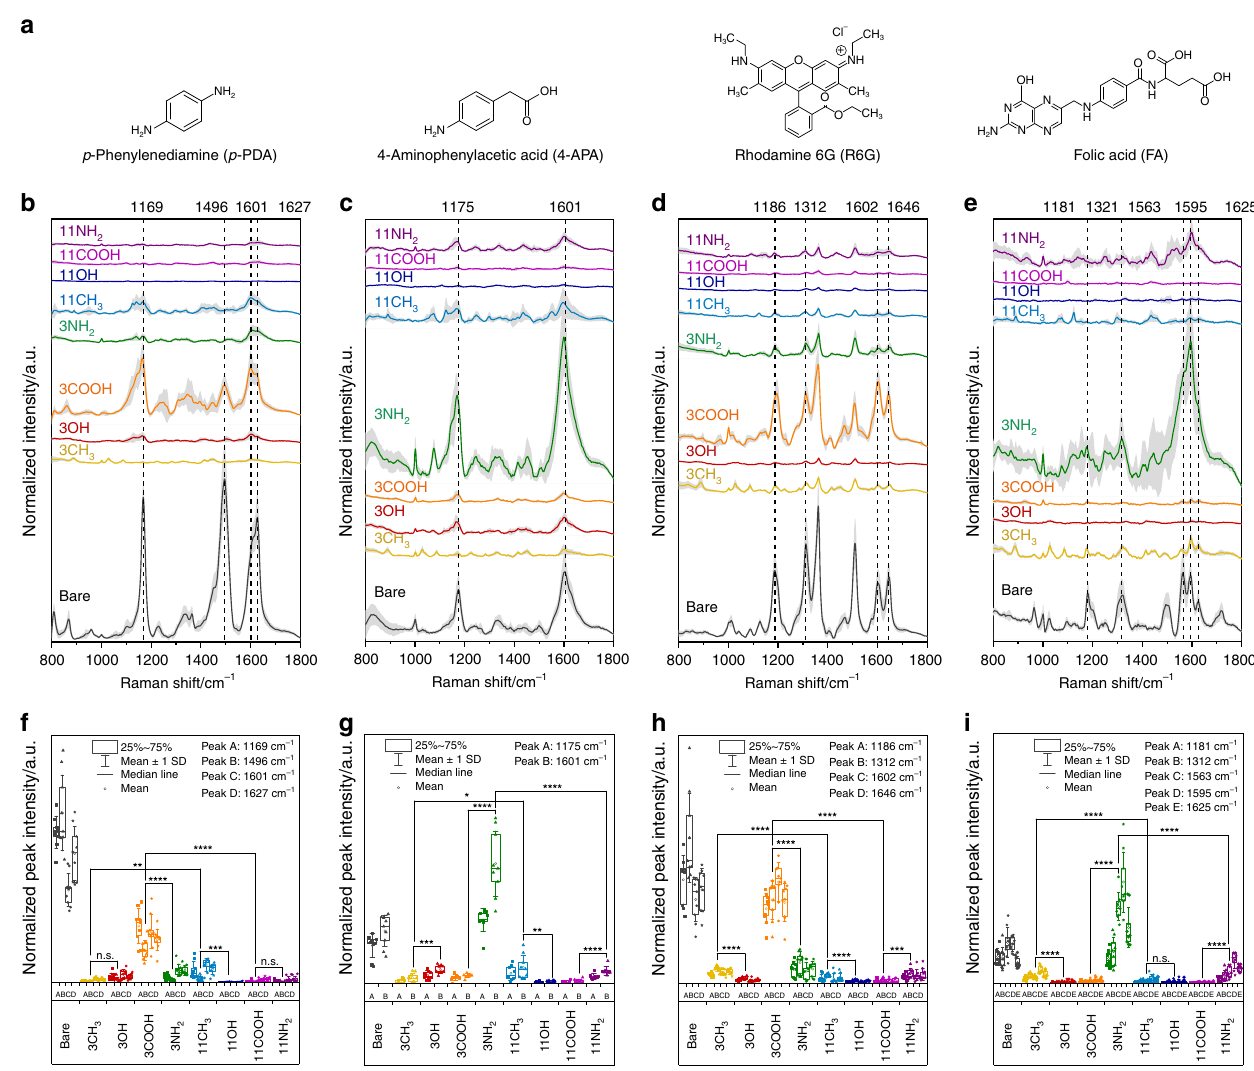
Fig. 3 Physicochemical SERS fi ngerprints of molecular analytes using FASERS. a Chemical structures of the four model analyte molecules. b – e Series of SERS spectra obtained from functionalized Au-nanopillars with various SAM-forming molecules: non-functionalized (bare), 1-propanethiol (3CH 3 ), 3- mercapto-1-propanol (3OH), 3-mercaptopropionic acid (3COOH), 3-amino-1-propanethiol (3NH 2 ), 1-undecanethiol (11CH 3 ), 11-mercapto-1-undecanol (11OH), 11-mercaptoundecanoic acid (11COOH), 11-amino-1-undecanethiol (11NH 2 ). b 500 µ M p -phenylenediamine ( p -PDA) in phosphate buffer (10 mM, pH 5.0), c 500 µ M 4-aminophenylacetic acid (4-APA) in phosphate buffer (10 mM, pH 7.5), d 100 µ M Rhodamine 6 g (R6G) in phosphate buffer (10 mM, pH 5.0), and e 500 µ M folic acid (FA) in phosphate buffer (10 mM, pH 7.5). Solid lines and grey shaded areas represent mean and ± 1 s.d. of nine obtained spectra ( N = 3, n = 3 spectra). f – i Peak analysis on the prominent peaks of the solutions; f p -PDA, g 4-APA, h R6G and i FA. Data represent the peak intensities determined from the nine spectra ( N = 3, n = 3 spectra). **** p < 0.0001, *** p < 0.001, ** p < 0.01 and * p < 0.05 based on one ‐ way ANOVA and Tukey ’ s honest signi fi cance